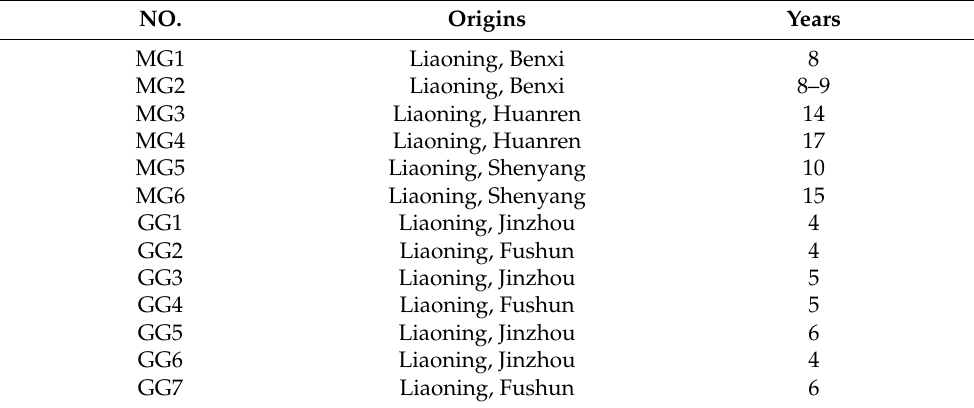
Table 1. A summary of the tested samples of Ginseng .